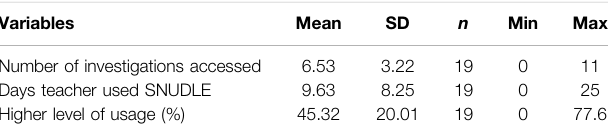
TABLE 4 | Description of fi delity of implementation measures aggregated to the teacher/classroom level for cohort 1 and